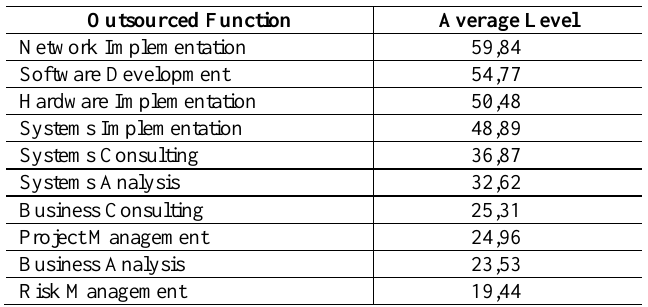
Table 3: Average level of outsourcing for outsourced function